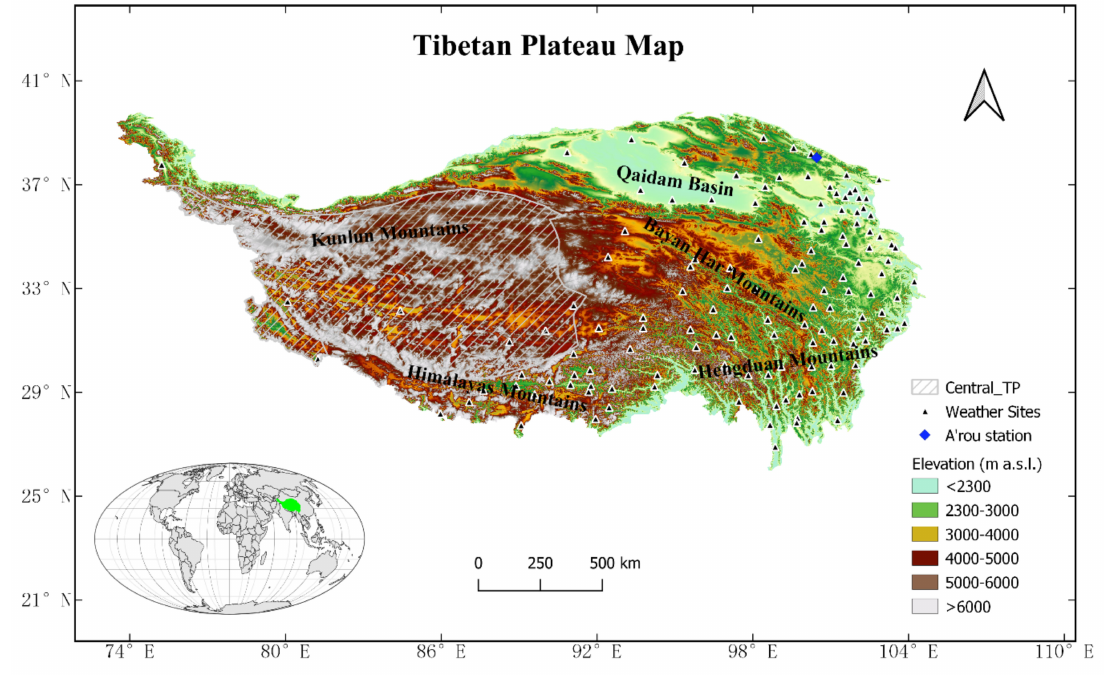
Figure 1. Location of TP, distribution of 130 weather stations and A’rou